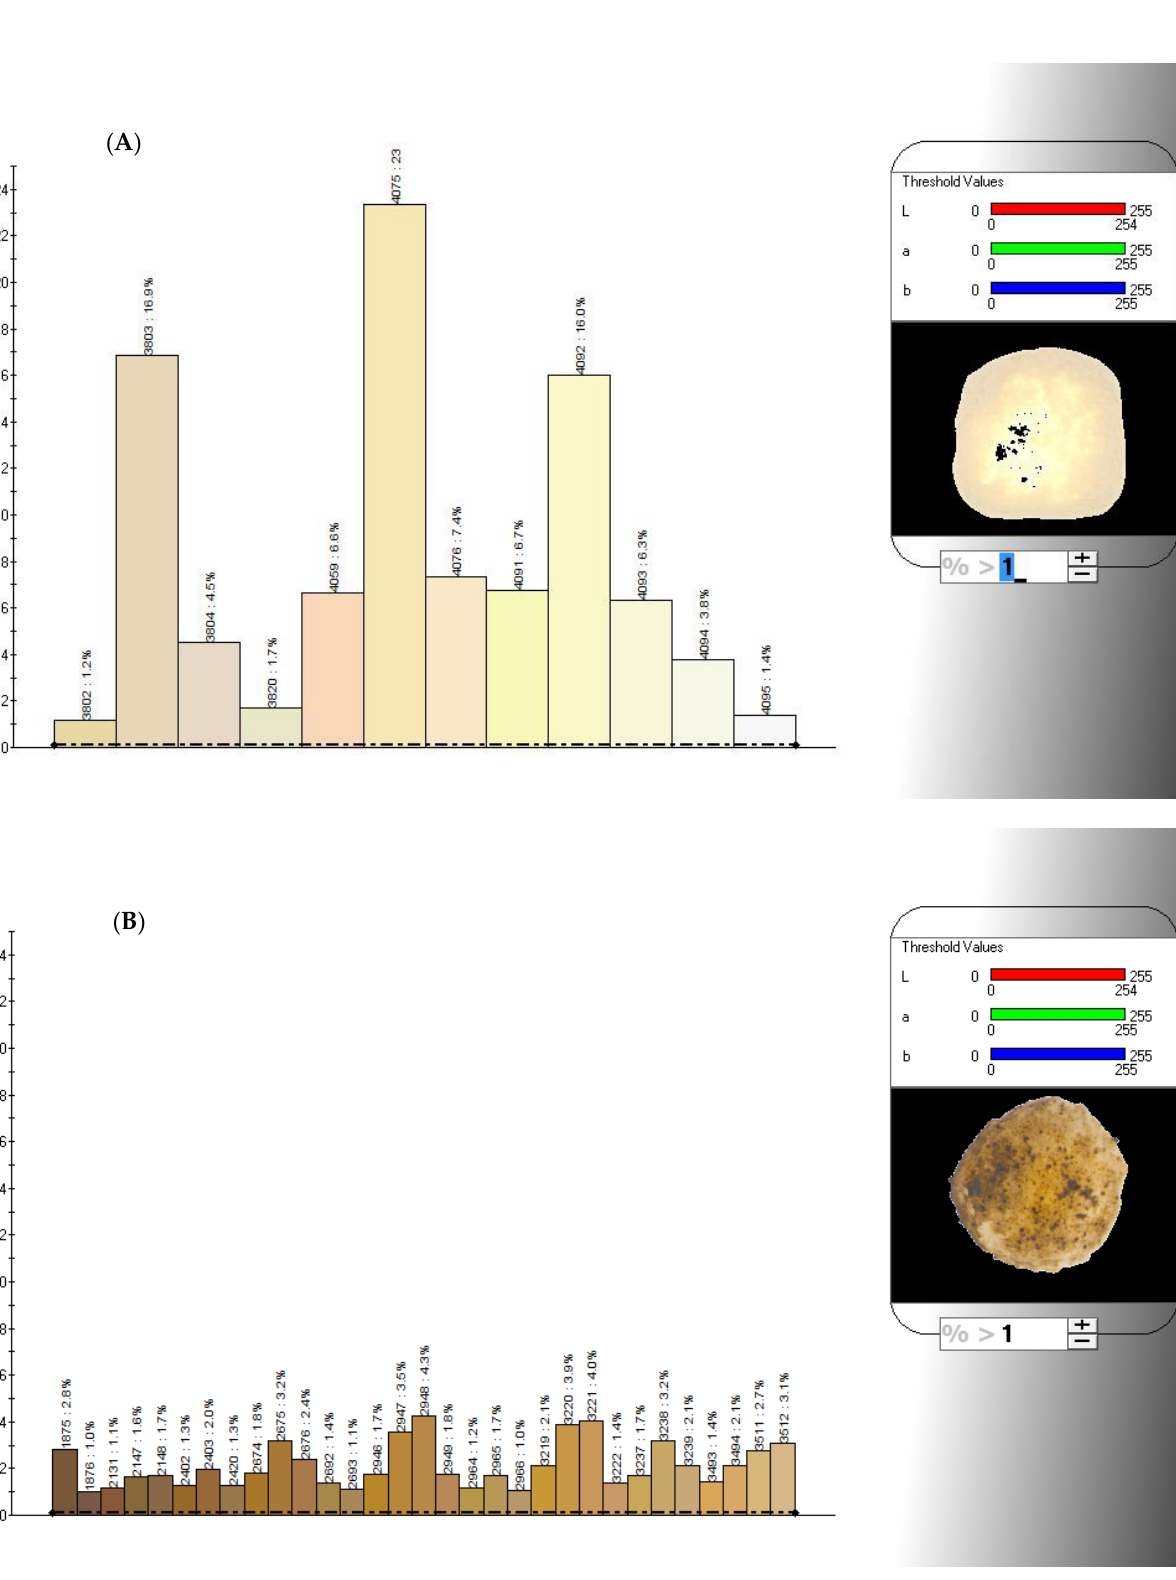
Figure 7. Color spectra of the upper side of pizza sample A (cf. Table 1) as freshly prepared ( A ) or after its baking in the pilot-scale wood-fired oven for 80 s ( B ), where the horizontal axis reports the color decimal code within a scale of 4096 colors and the vertical axis shows the percentage of the pizza surface area occupied by the corresponding color decimal code. The color spectra show the only colors occupying a percentage of the pizza surface area greater than 1%.